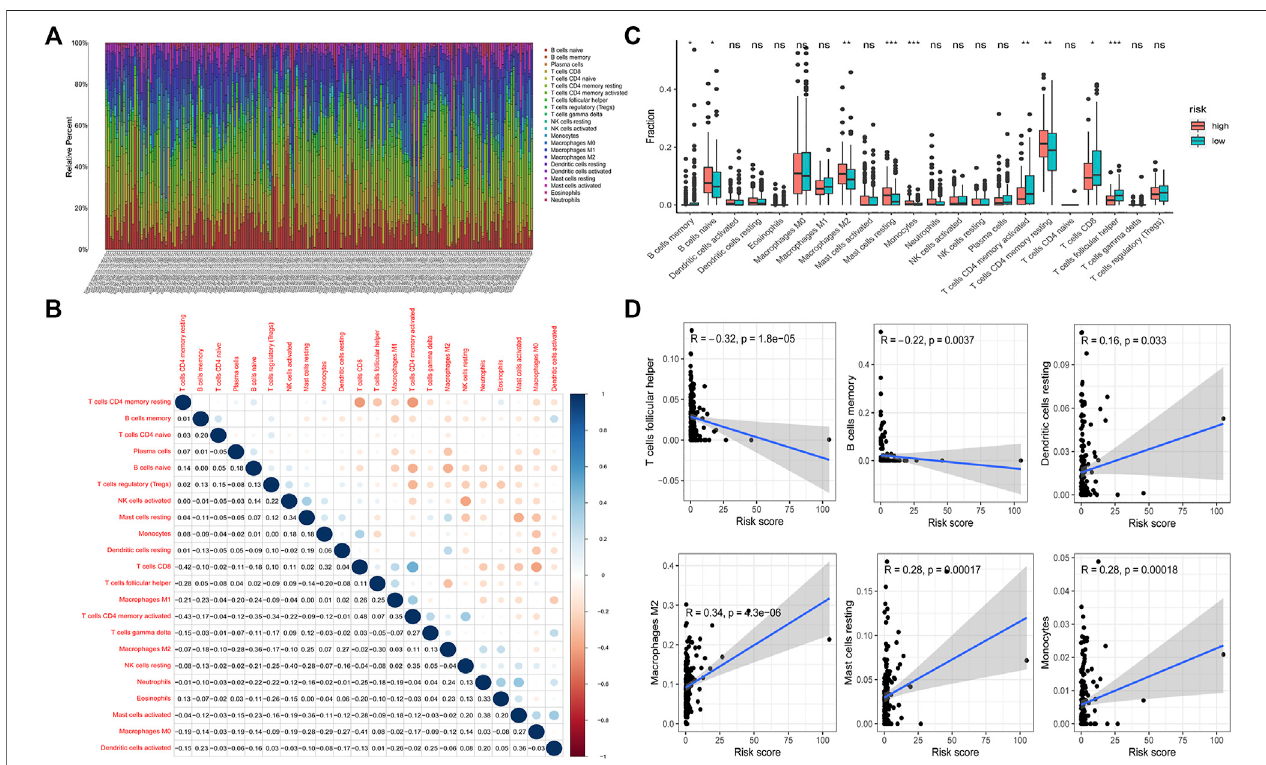
FIGURE 6 | Tumor in fi ltrating immune cells in GC. CIBERSORT calculation method was used to calculate the in fi ltrating level of 22 tumor immune cells in GC patients (A) .Correlation between 22tumor in fi ltratingimmune cells wasvisualized.The red plot representsthe negative correlation between twoimmunecells, whilethe blue plot represents the positive correlation between two immune cells. The larger the shape of the point, the stronger the correlation (B) . The difference of the tumor in fi ltrating immune cells between the low-risk group and high-risk group (* p < 0.05, ** p < 0.01, *** p < 0.001) (C) . Correlation between the risk score and in fi ltrating level of T cells follicular helper, B cells memory, dendritic cells resting, macrophages M2, mast cells resting and monocytes (D) .